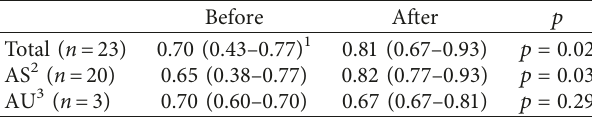
Table 3: EQ-5D index score before and after revascularisation. Before